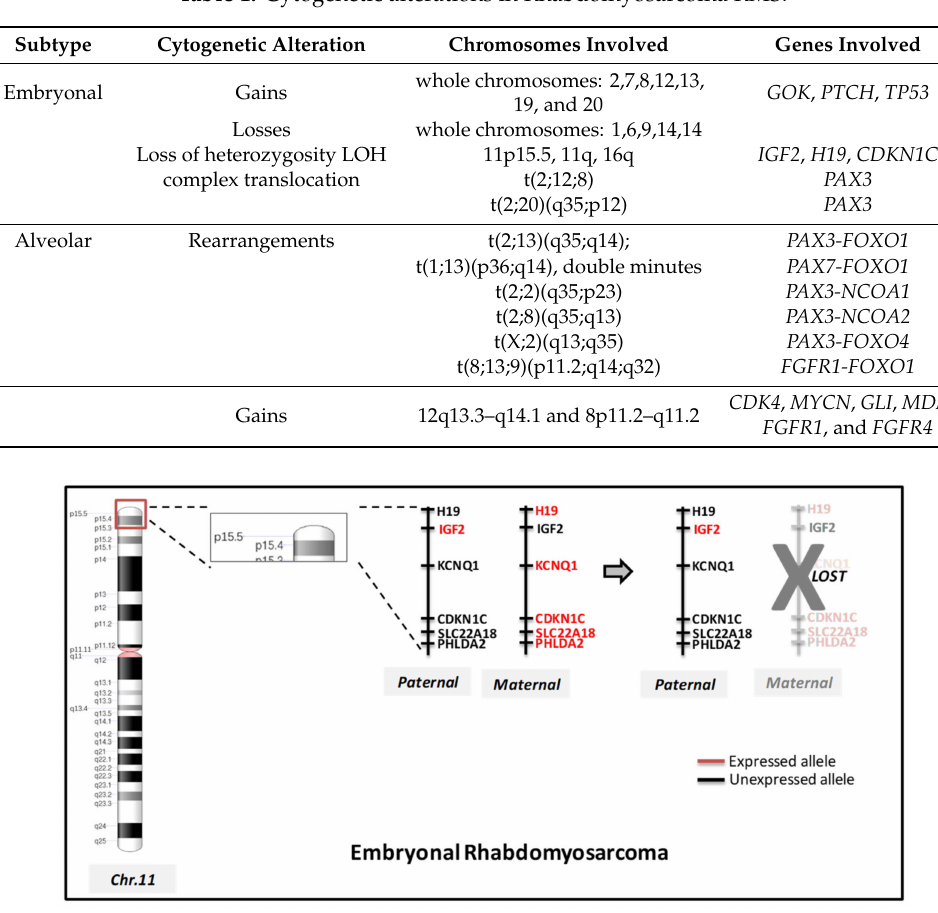
Figure 1. Allelic loss of imprinted region at 11p15.5. The chromosomal ideogram of 11p15.5 illustrates imprinting of genes alleles included in that specific region according to parent-of-origin. Particularly in embryonal RMS ERMS, the maternal allele is lost, through loss of heterozygosity, resulting in the presence of only the paternal